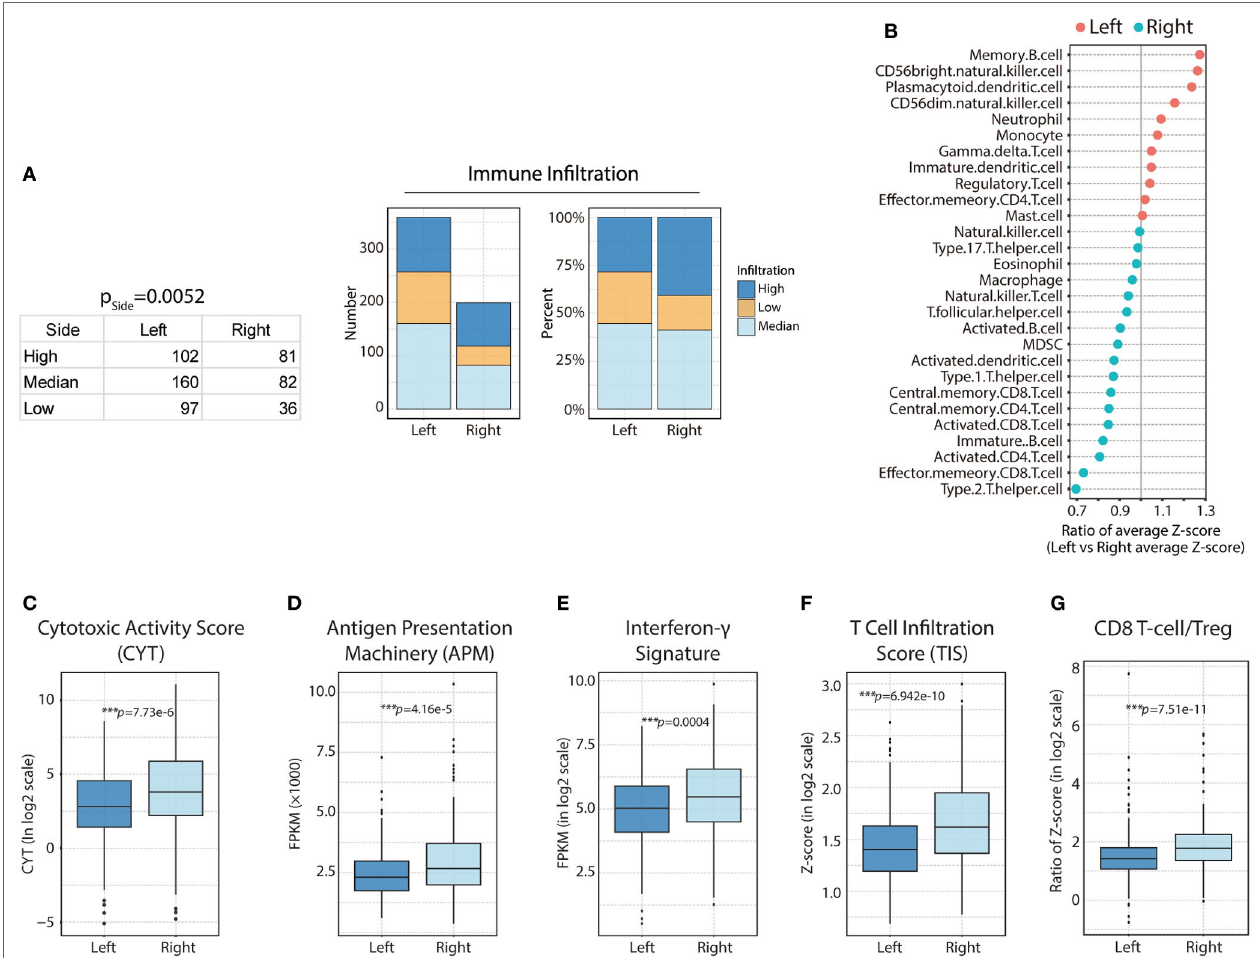
FigUre 2 | Heterogeneous immune cell infiltration in right-side and left-side colorectal cancer (CRC). (a) Immune infiltration in right-side and left-side CRC based on immune infiltration clustering scores [right side: high (H) = 81; median (M) = 82; low (L) = 36 vs left side: H = 102; M = 160; L = 97, p = 0.0052]; the absolute value and composition ratio of different immune infiltration statuses are show on the right. (B) Distribution of immune cell infiltration between different primary tumor locations. Higher than 1, more infiltration in left side; lower than 1, less infiltration in right side. (c) Comparison of relative cytotoxic activity scores (CYT) between right- and left-side CRC ( p = 7.73e − 6). (D) Relative antigen presentation machinery (APM) between right-side and left-side CRC ( p = 4.16e − 5). (e) Relative interferon- γ signature between right- and left-side CRC ( p = 0.0004). (F) Relative T-cell infiltration score (TIS) between right- and left-side CRC ( p = 6.942e − 10). (g) Relative CD8 T-cell/Treg ratios between right- and left-side CRC ( p = 7.51e − 11). Two-tailed Student’s t -tests were used for all analyses. Error bars represent the